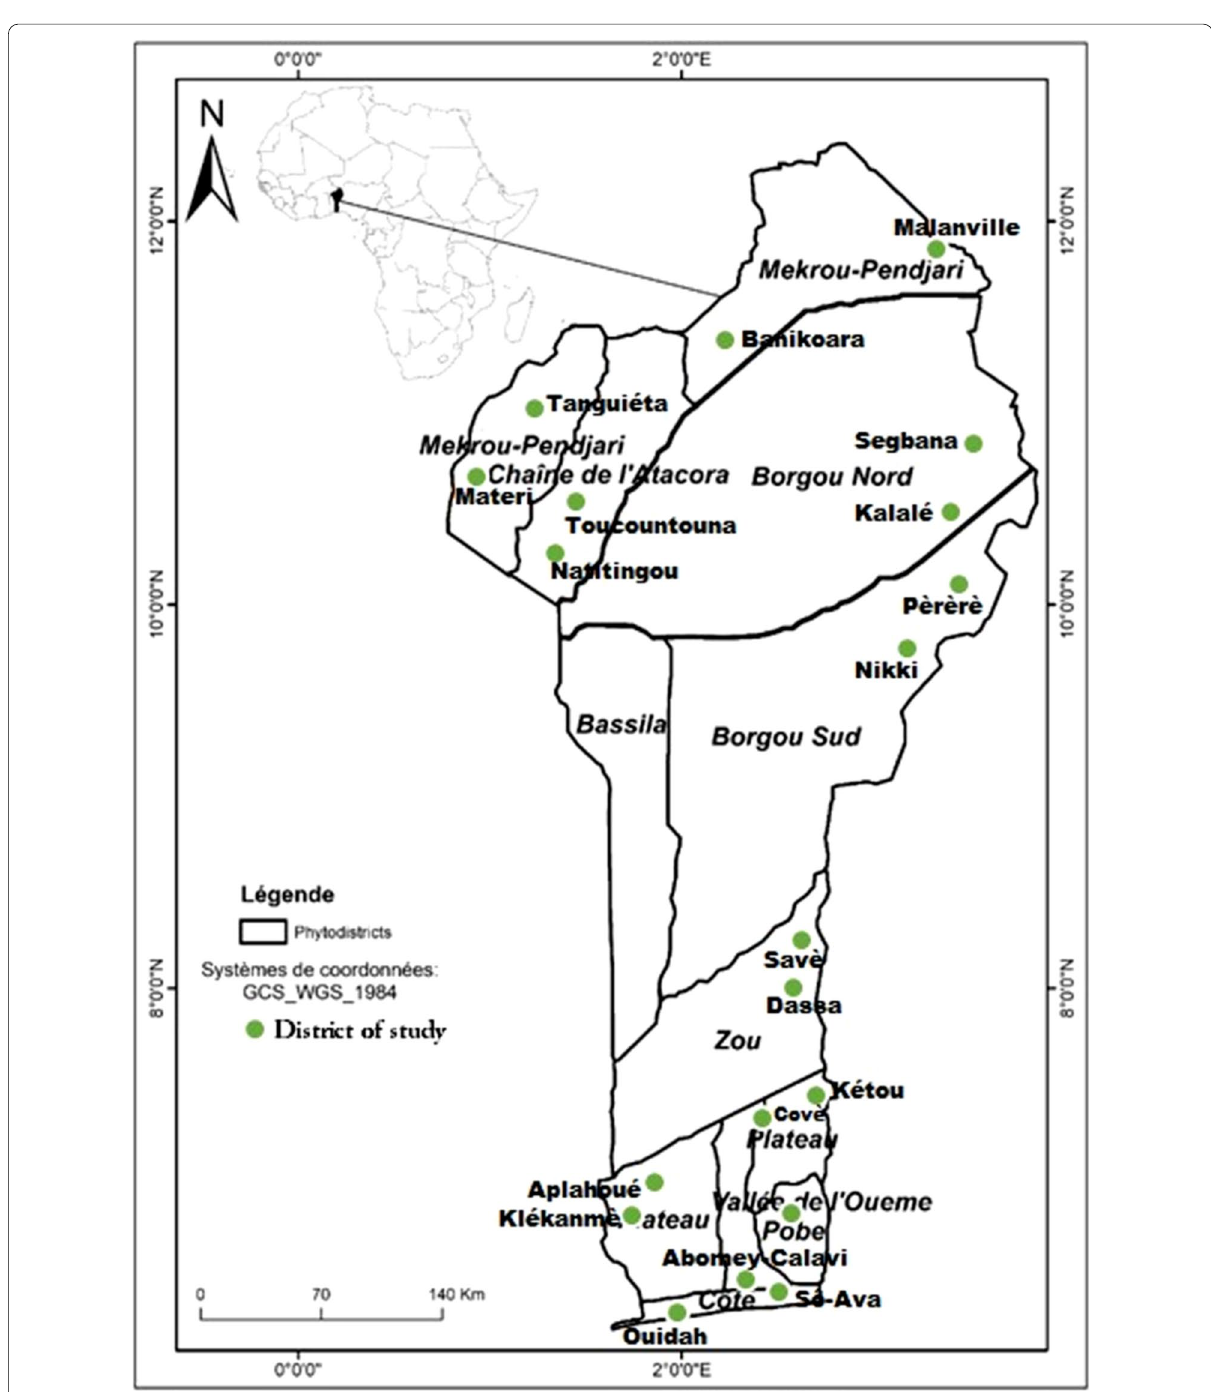
Fig. 1 Map of Bénin showing the location of the studied phytodistricts. Inset is a map showing the location of Benin on the African